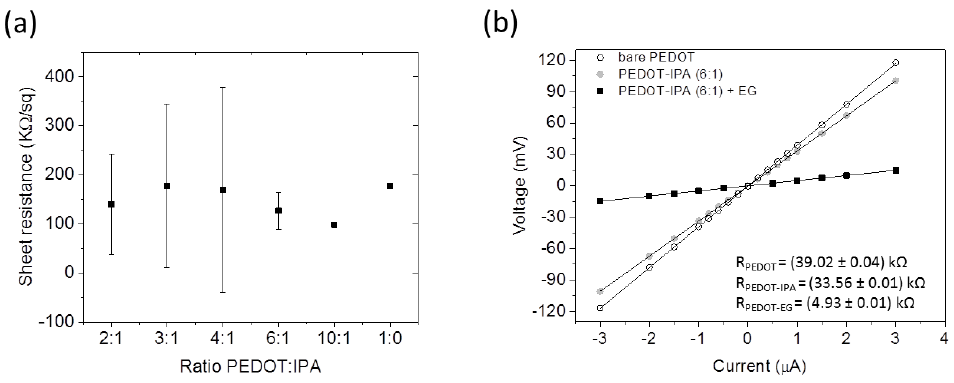
Figure 3. ( a ) Effect of PEDOT:IPA solution concentration on obtained film resistance (error bars represent one standard deviation on 4 measurements); ( b ) Voltage/Current curves measured on a spin-coated film (1000 rpm, 30 s, 500 rpm/s) made of PEDOT: PSS (empty circles), PEDOT-IPA 6:1 (grey circles) and after the treatment with ethylene glycol (black square). Lines correspond to the linear fit for each curve.